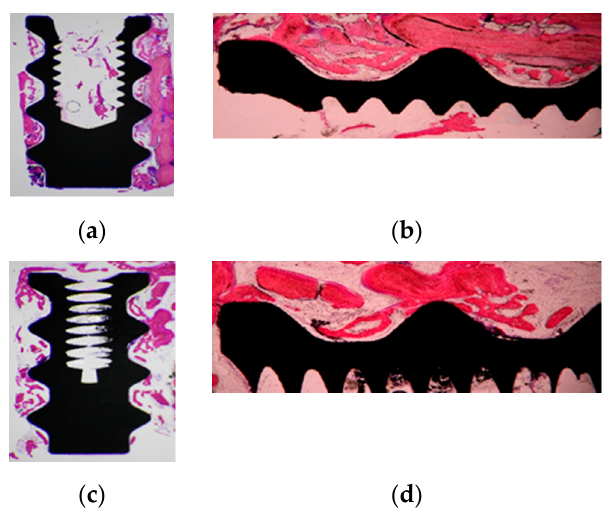
Figure 5. Histomorphometric examination of micro-implant of control ( a , b ) and T2DM group ( c , d ). T2DM group showed less bone implant contact (BIC) and new bone formation inside the implant thread.